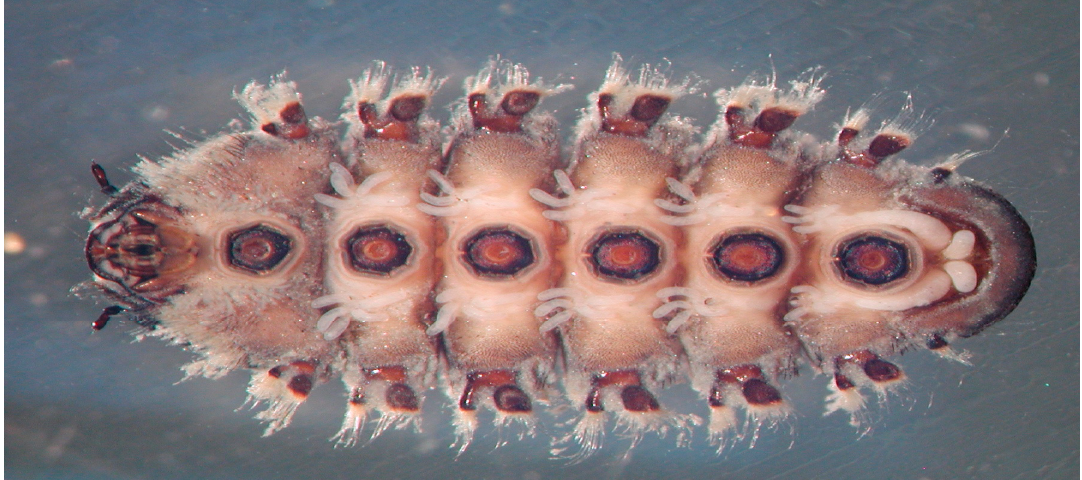
Figure 2. Ventral suckers of a Blephariceriidae larva (Photo Stefano Fenoglio).